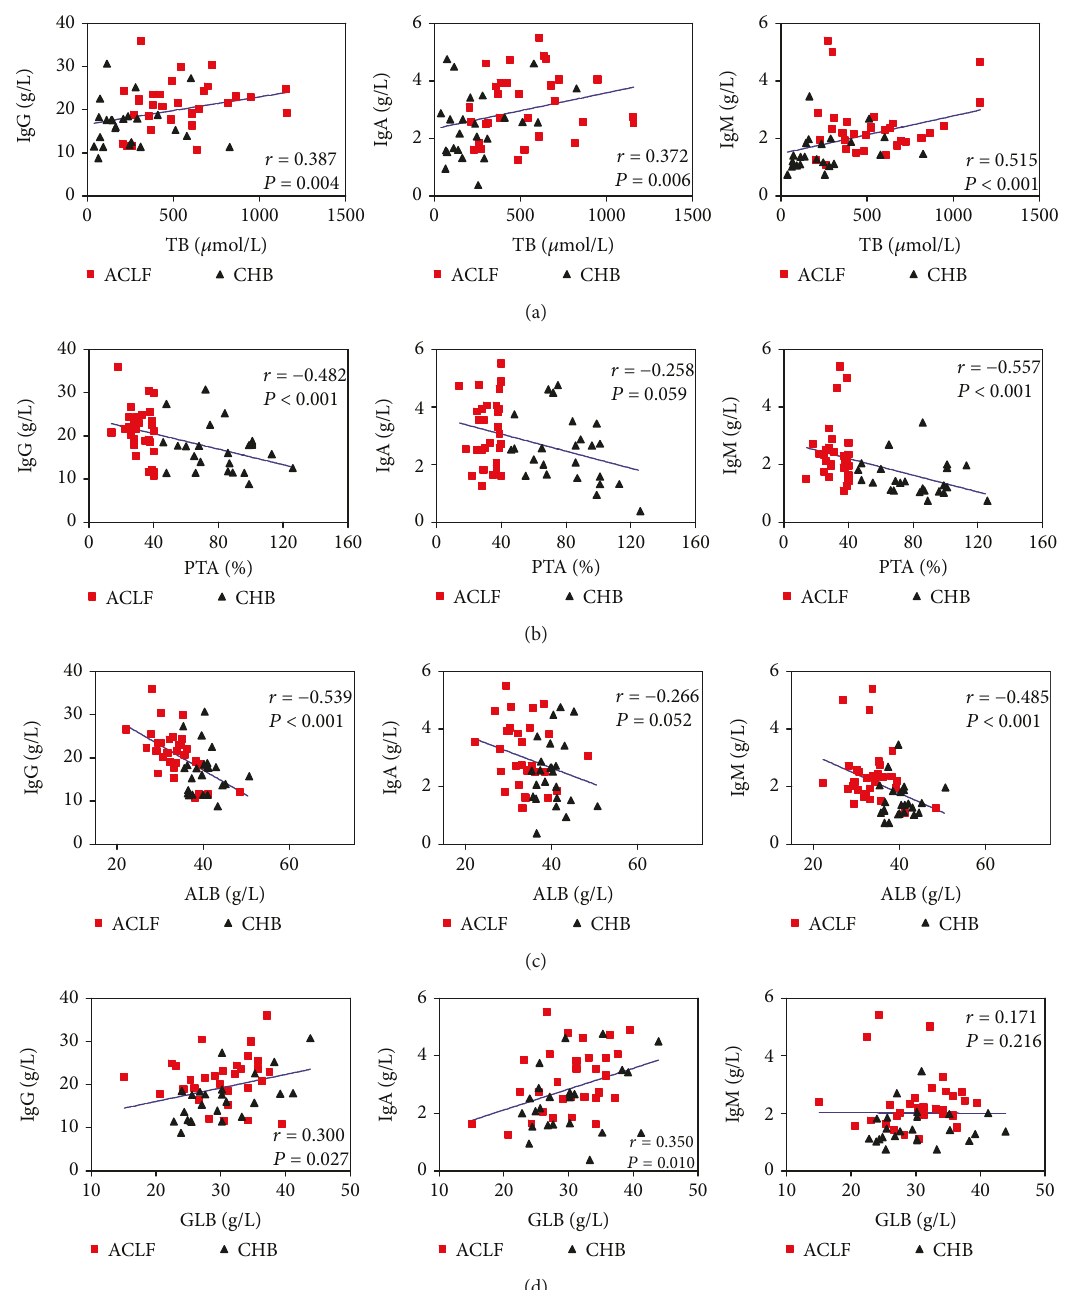
Figure 2: Elevated serum IgG, IgA, and IgM may contribute to liver injury. Serum IgG, IgA, and IgM levels were positively correlated with serum total bilirubin (TB) levels (a) but negatively associated with plasma prothrombin time activity (PTA) levels (b) and serum albumin (ALB) levels (c). In addition, positive correlations were found between immunoglobulin (IgG and IgA) and serum globulin (GLB) levels (d) in HBV-infected patients. Solid line: linear growth trend; r : correlation coe ffi cient. P values are